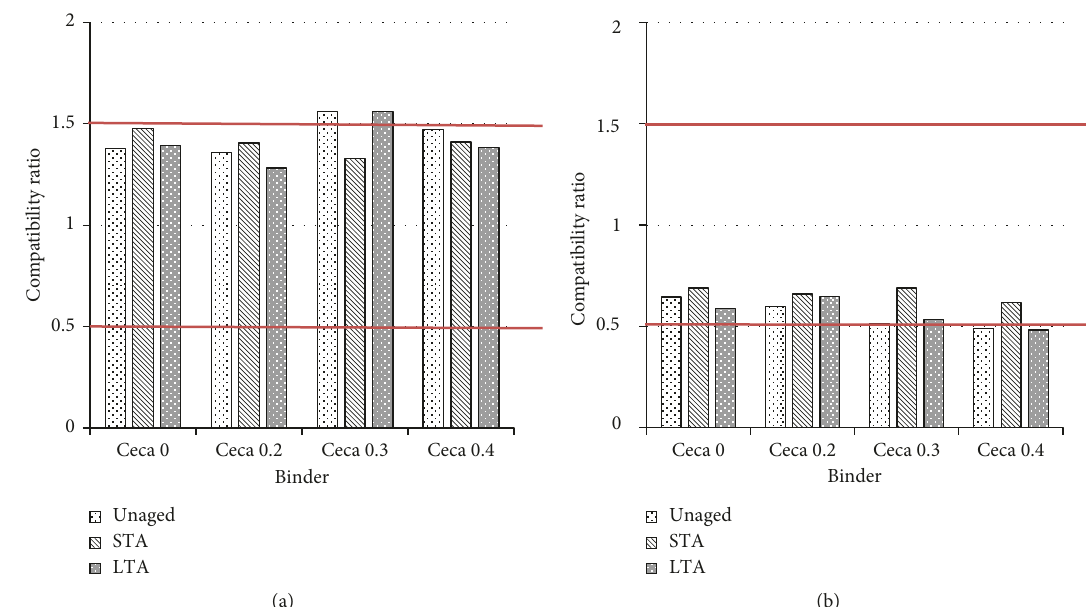
Figure 13: Compatibility ratio of PG-76 asphalt binder: (a) limestone; (b)